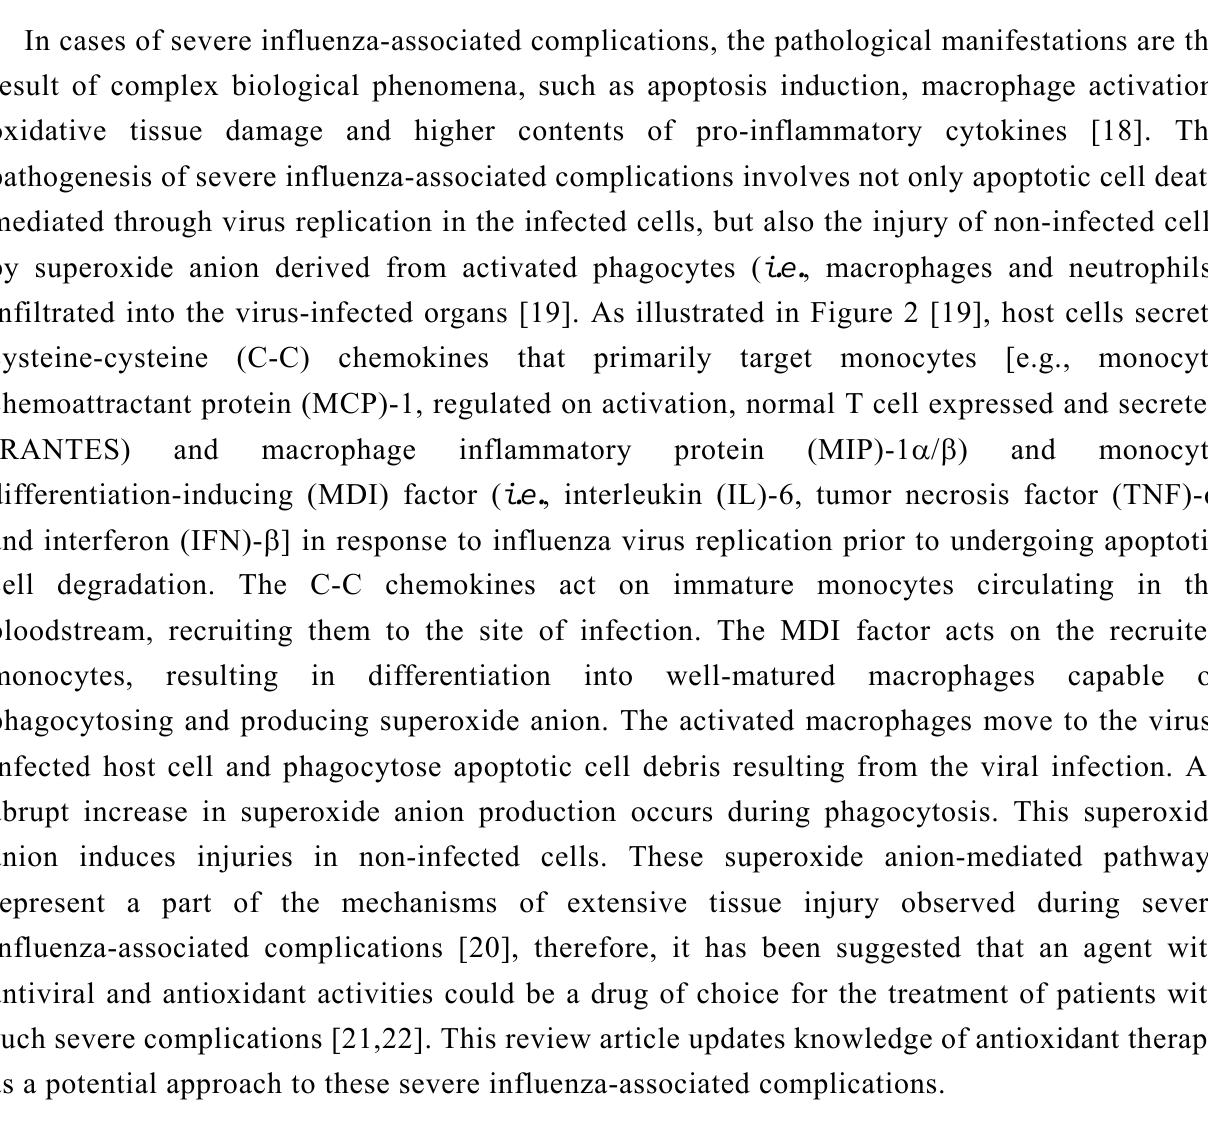
Figure 2. Tissue injury model during influenza virus